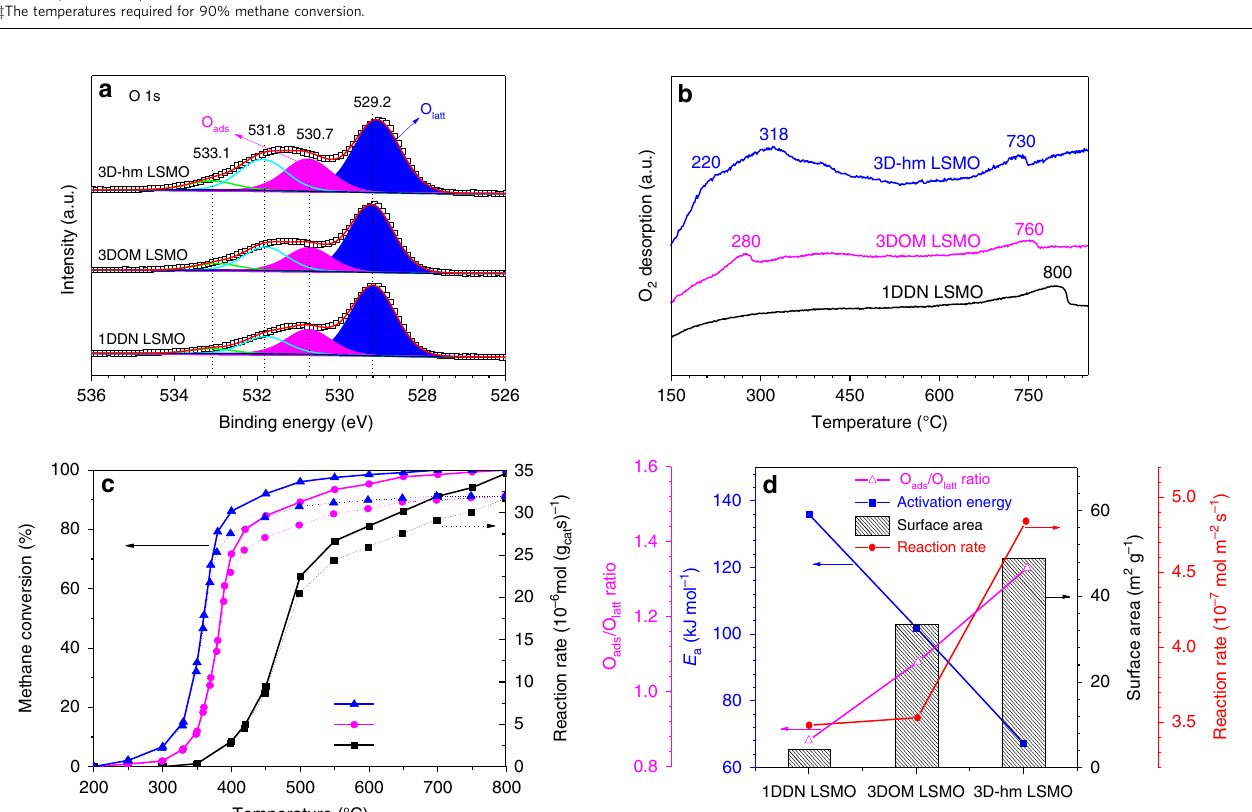
Figure 4 | Oxygen species analysis and catalytic performance over LSMO catalysts. ( a ) O 1s XPS spectra, ( b ) O 2 -TPD profiles, ( c ) methane combustion activities for the 1DDN, 3DOM and 3D-hm LSMO samples, and ( d ) the association activation energy and reaction rate has with surface oxygen composition (O ads /O latt ratio) and BET surface area for the LSMO samples. surface area (48.9 m 2 g (cid:3) 1 ) and the highest surface Mn 4 þ /Mn 3 þ molar ratio (1.51), as shown in Table 1 and Supplementary Fig. 15. According to Fig. 4a, the fractions of the components in the O 1s spectra that are attributed to surface lattice O 2 (cid:3) (O latt ), adsorbed oxygen (O ads ), hydroxyl and/or carbonate groups and adsorbed water species vary non-monotonically with the different LSMO morphologies. The O ads /O latt molar ratio increases from 0.35 to 0.44 upon using the fragmentation protocol (Supplemen- tary Table 3). The result is consistent with the O 2 -temperature programmed desorption (TPD) result (Fig. 4b), which reveals two desorption peaks, one below and one above 400 (cid:2) C, indicating the LSMO sample performs the best in terms of activity, giving T 10% , release of O ads and O latt species, respectively 11 . On comparing the T 50% and T 90% values of 310, 360 and 438 (cid:2) C, respectively, which 3D-hm and 3DOM LSMO samples, the 3D-hm LSMO possesses a much larger and broader O ads desorption peak (spanning 200 to 400 (cid:2) C) as well as a shift in the O latt peak to a lower temperature (730 (cid:2) C). The result demonstrates that the fragmentation process CH 4 conversion was maintained at 650 (cid:2) C for 50 h of on-stream provides an LSMO surface enriched in O ads species and improves reaction. Kinetic studies were performed across a temperature NATURE COMMUNICATIONS|8:15553|DOI: